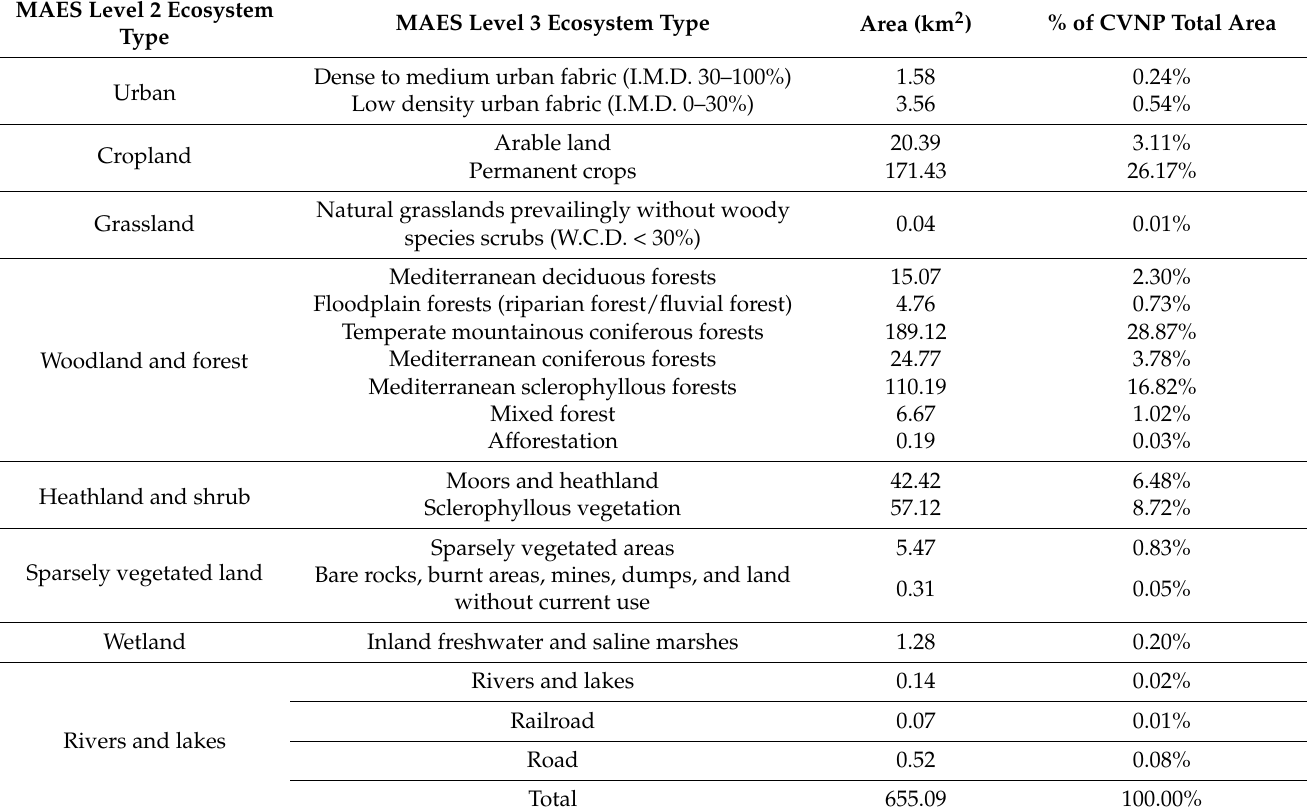
Table 5. Ecosystem types area cover and their percentage with respect to CVNP